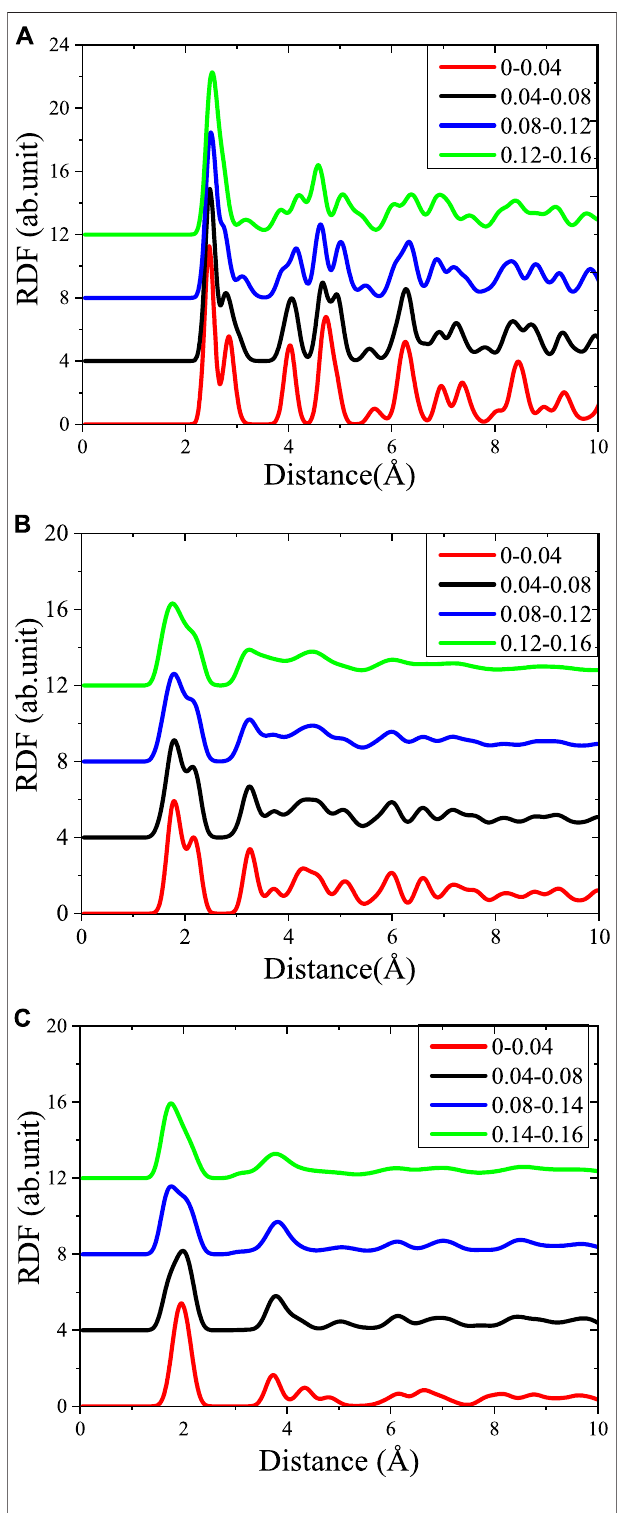
FIGURE 4 | The Radial distribution function (RDF) curve of the different stages in the stretching process (A) Fe – Fe in Fe structure, (B) Fe – O s in γ -Fe γ -FeOOH structure. 2 O 3 structure, and (C) Fe-O s in